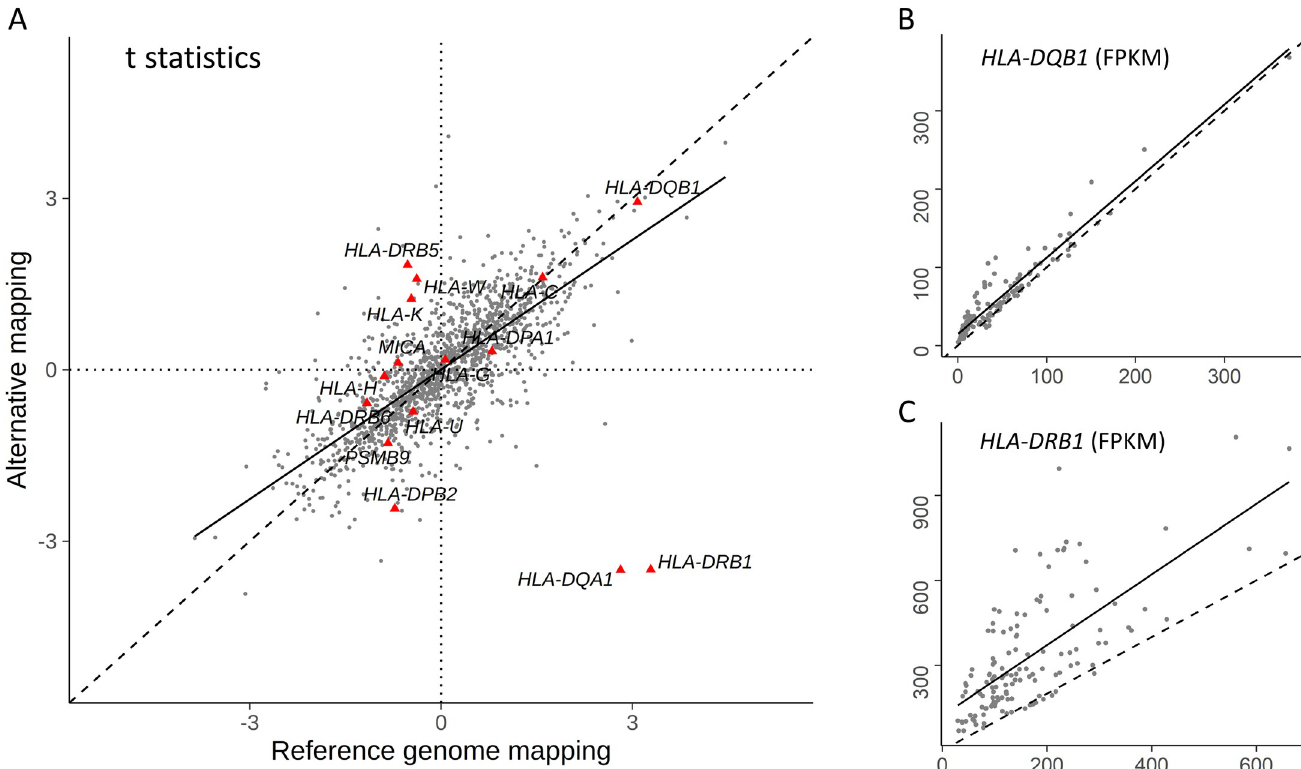
Fig 7. Effect of allele bias on gene expression quantification and disease phenotype association in CF nasal epithelial biopsy RNA-seq data set. Comparison of CF lung disease (KNoRMA) association t statistics between different mapping protocols among 1,379 common imputable genes by respective predictive models among 5,634 unrelated CF patients are shown in A. HLA genes in A, are represented as red triangles, and x-axis represent standard and y-axis alternative mapping protocols. Panels B and C show gene expression quantifications by standard (x-axis) and alternative (y-axis) protocols in the format of FPKM for HLA-DQB1 , and HLA-DRB1 genes. Each dot represents 1 sample (out of 132 total), with solid line denoting linear regression line, and dashed line representing equality.